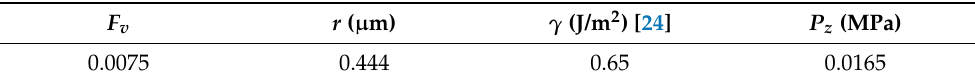
Table 6. Parameters of secondary particles in the modified alloy after the solution processing at 1093 K for 1